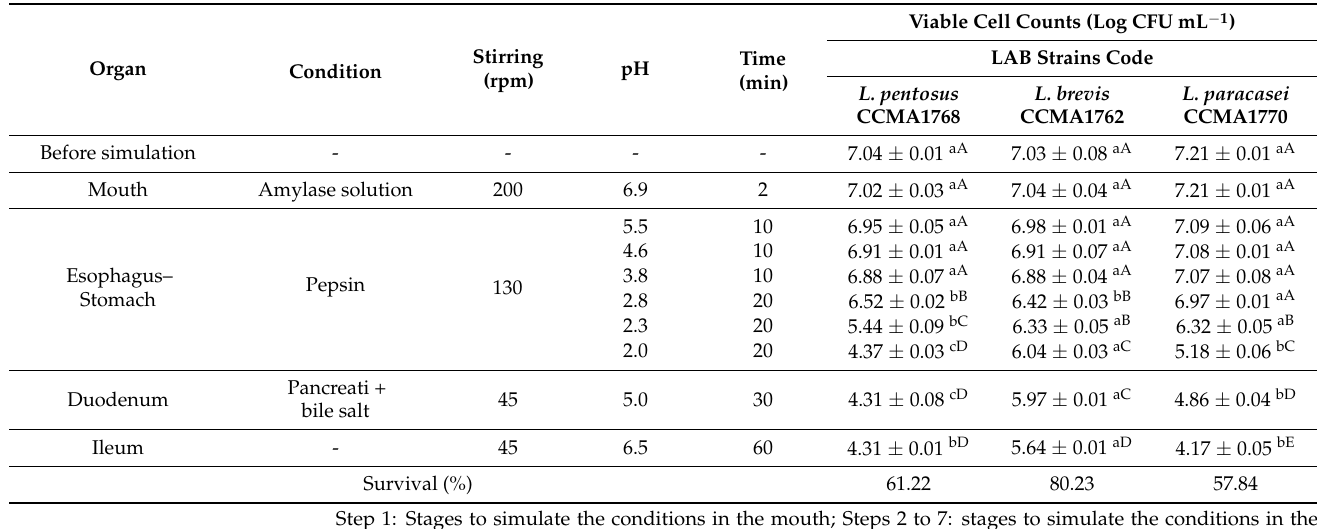
Table 4. Conditions used during the simulated digestion and the resultant viable cell counts of different LAB strains.